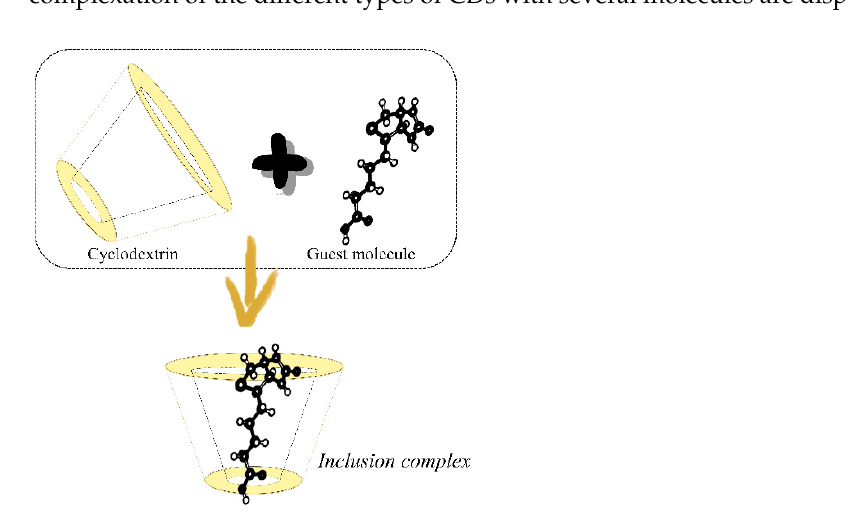
Figure 1. Representation of the entrapment of a guest molecule in the cyclodextrin’s cavity. Table 2. Inclusion complexes obtained with several types of guest molecules and cyclodextrins (CDs).